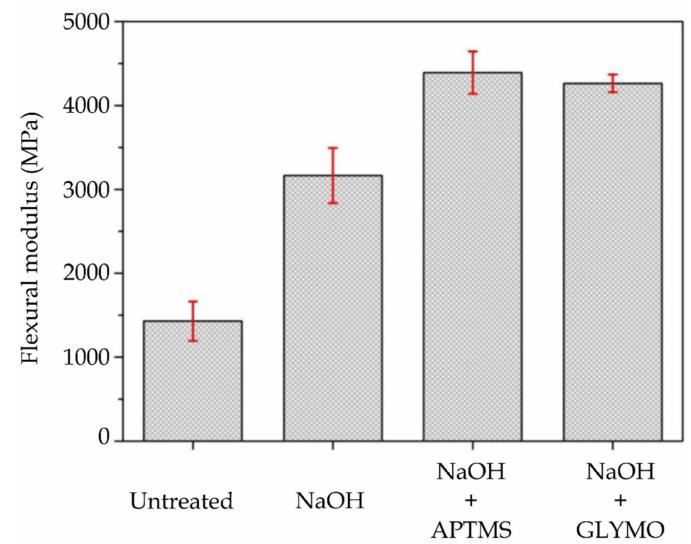
Figure 4. Bar plot of the flexural modulus of PO fibreboards with different surface treatments.